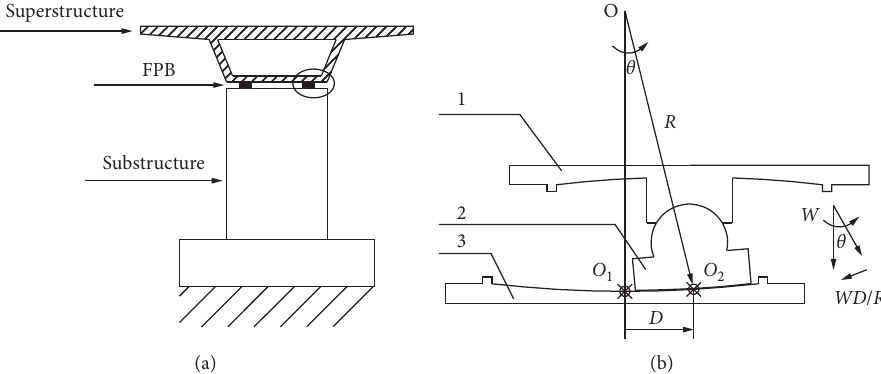
Figure 1: (a) Isolated bridge with 2 FPBs in view of the axial direction of the bridge. (b) Structural illustration of a FPB (circled in (a)), (1) upper support plate, (2) articulated slider, and (3) lower support